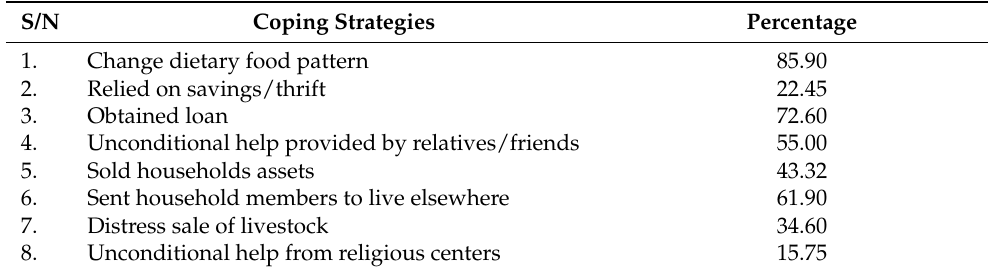
Table 8. Distribution of respondents based of coping strategies adopted against food insecurity during COVID-19